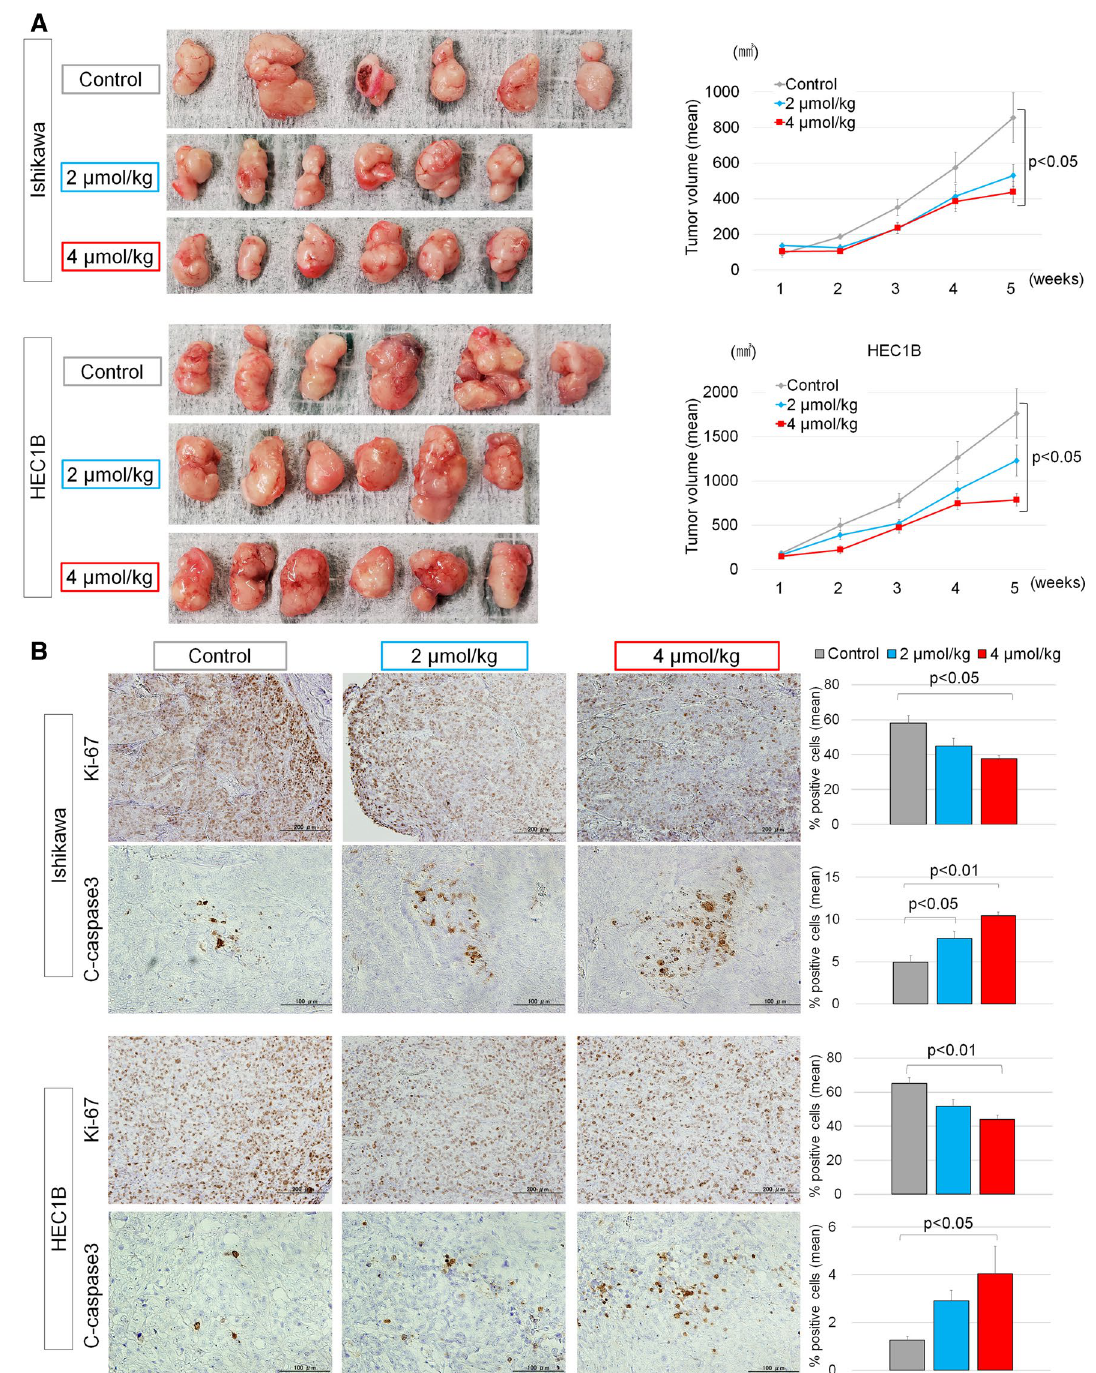
Fig. 3 A Effect of daily 6-MITC oral administration on Ishikawa and HEC1B xenograft tumor growth in nude mice. Xenografted mice were divided into three groups (Control, 2 µmol/kg-, and 4 µmol/kg-administered groups); each group had six mice. Pictures are at the same scale and show each tumor removed from each mouse after euthanization at 5 weeks. Graphs indicate mean values, and error bars indicate standard deviations. At 5 weeks, the tumor volume of the 4 µmol/kg-administered group was significantly decreased compared with the control group for both Ishikawa (P = 0.01) and HEC1B (P = 0.02) cells. B Immunohistochemical (IHC) results of the removed xenografts for Ki-67 and c-caspase3 are shown in pictures, and the average values of %-positive cells are indicated in graphs with standard deviations (error bars). 6-MITC administration reduced the expression of Ki-67 and enhanced c-caspase3 in both Ishikawa and HEC1B